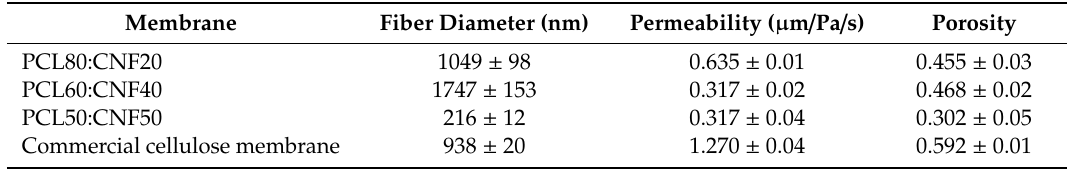
Table 1. Morphology of electro-spun nanofibers constituting the membranes. PCL = polycaprolactone and CNF = cellulose nanofiber.